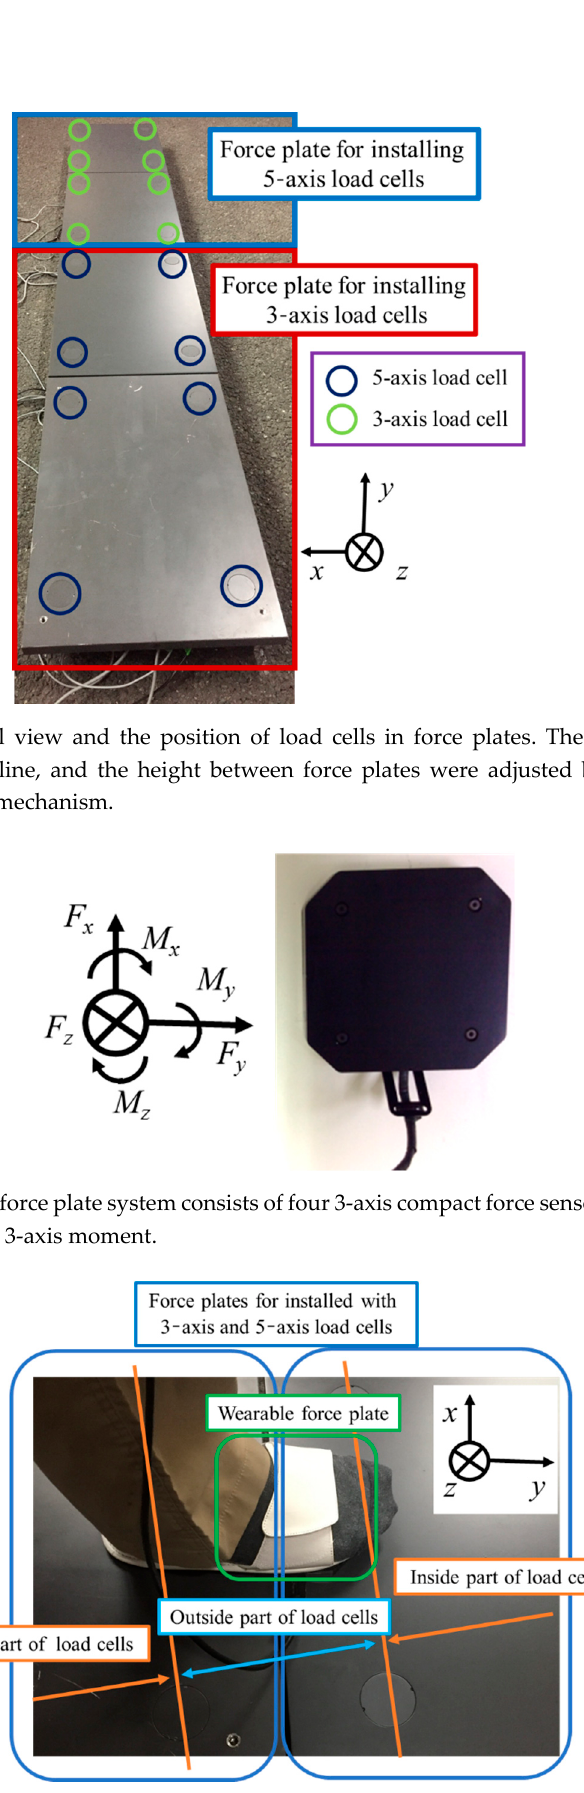
Figure 4. The view of experiment using the force plates installed with 3-axis and 5-axis load cells and the wearable force plate. In this experiment, the force is applied between the two force